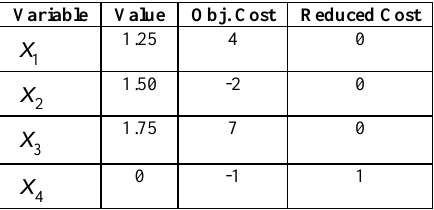
Table 1. Solution to the LP problem